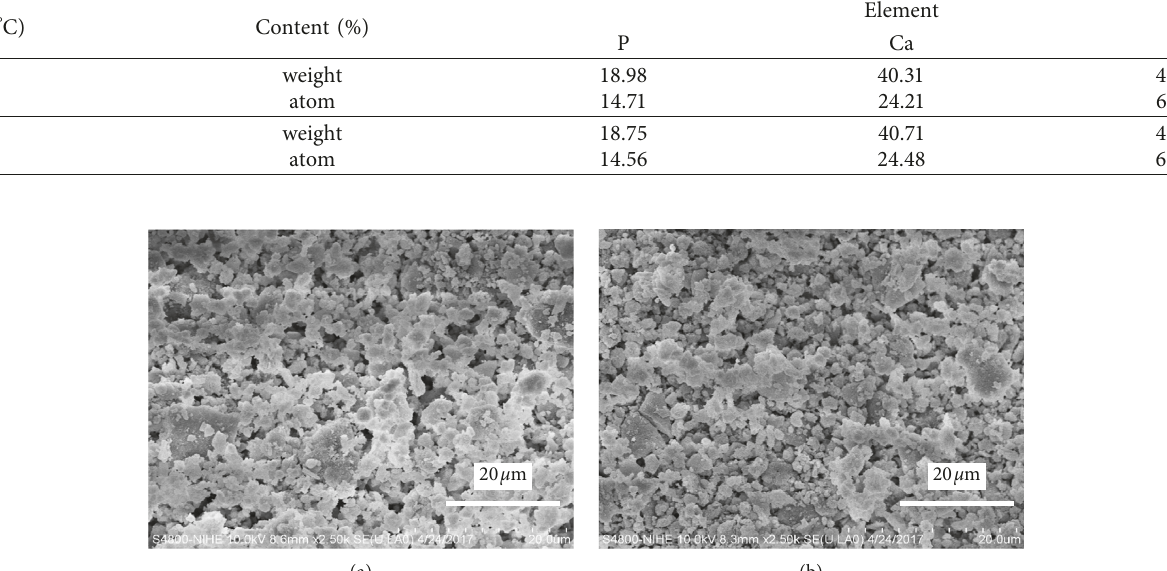
° C and 700 ° C. 3 granules sintered at 600